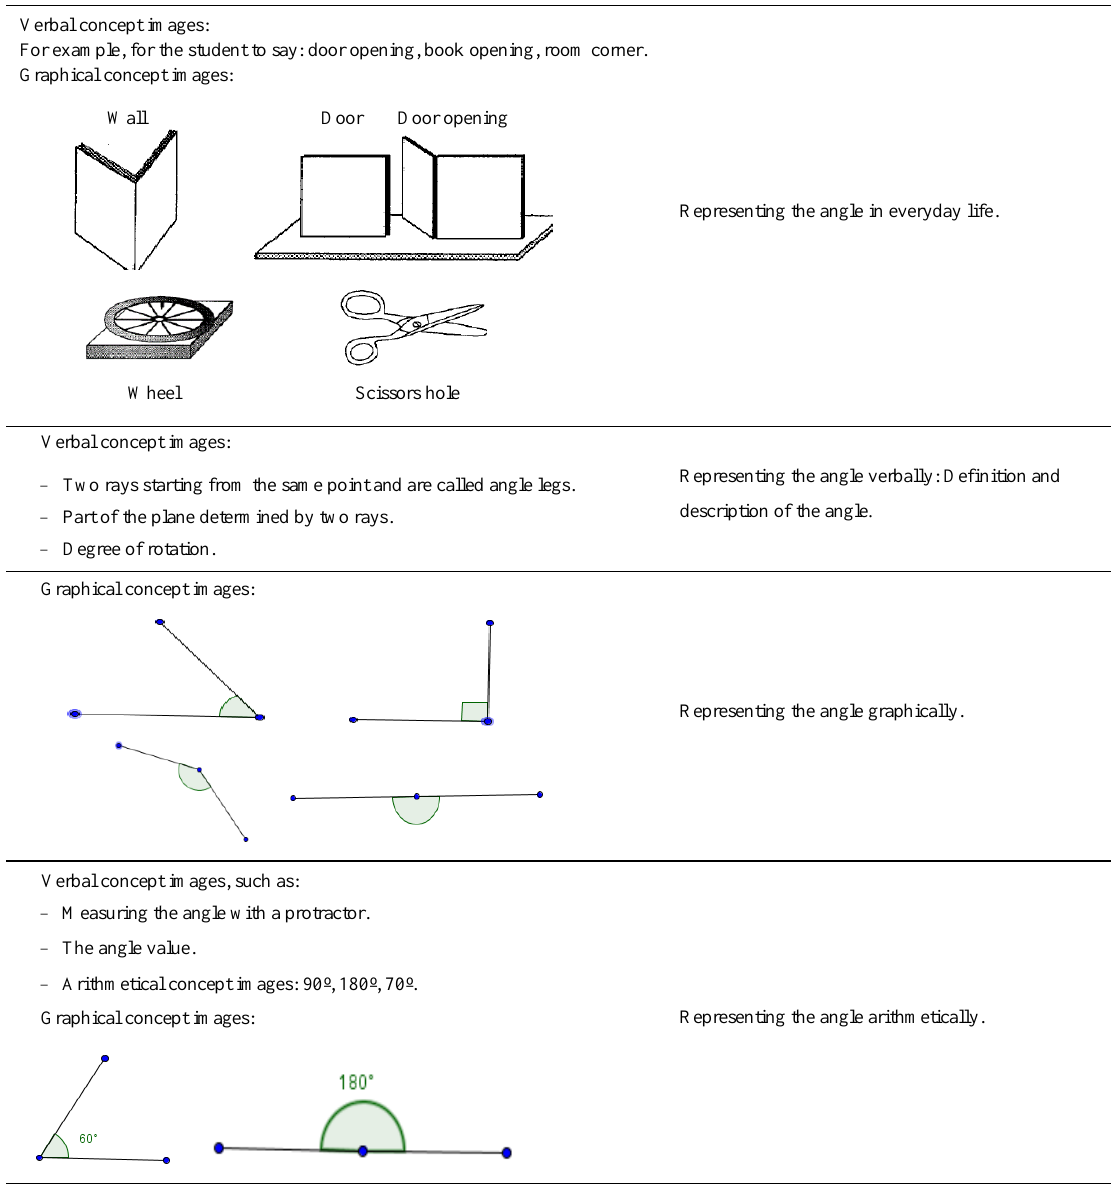
Representing the angle in everyday